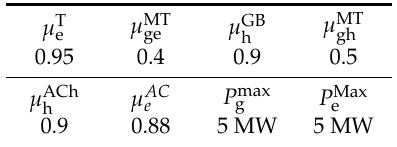
Table 2. Parameters for MT, EHe, GB, ACh, and Transformer Devices.